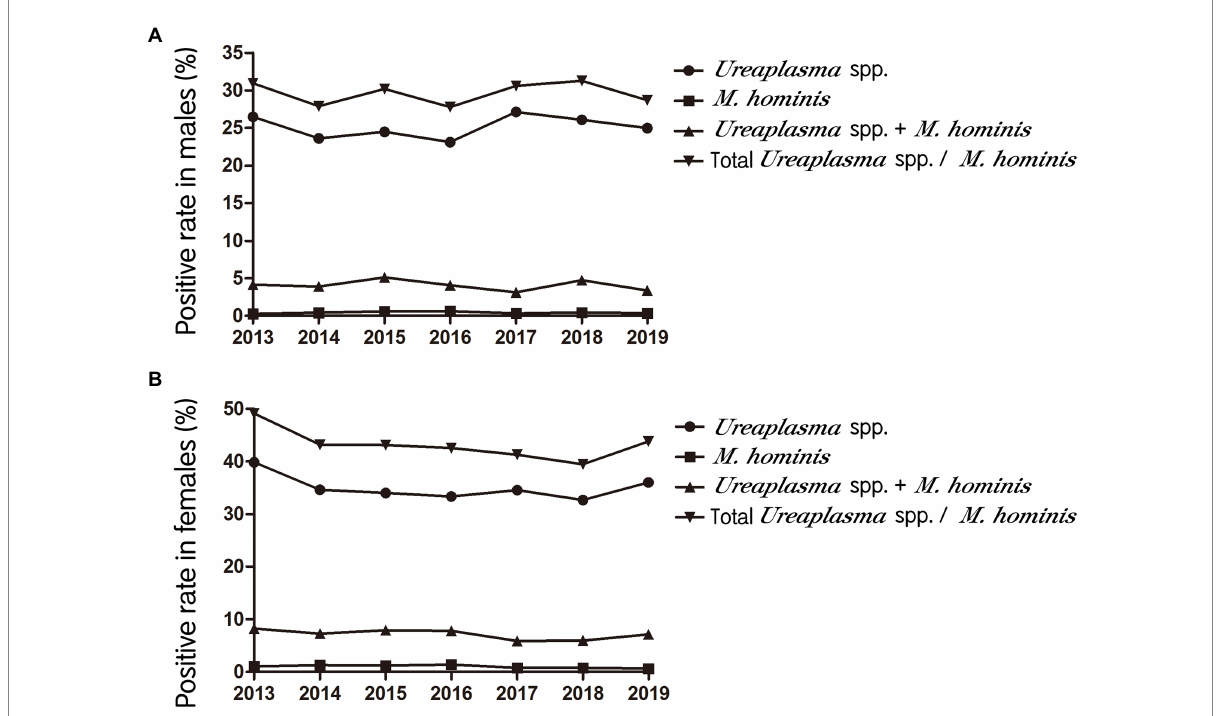
FIGURE 1 Trends in the prevalence of Ureaplasma spp. and Mycoplasma hominis in males (A) and females (B) from 2013 to